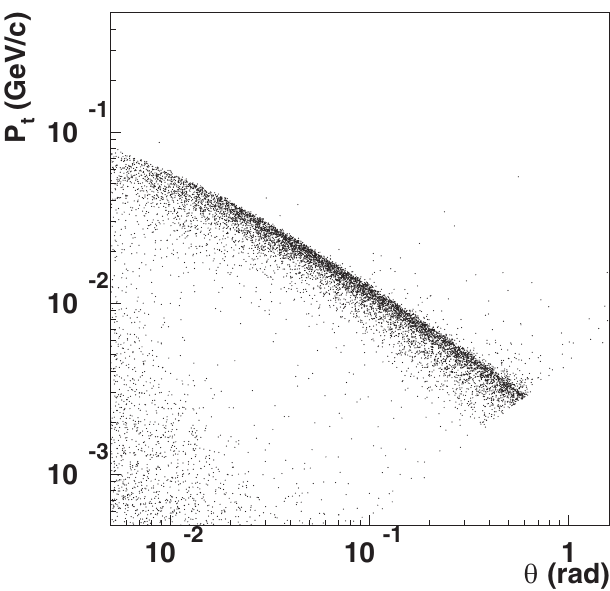
, versus polar angle, (cid:1) , for t